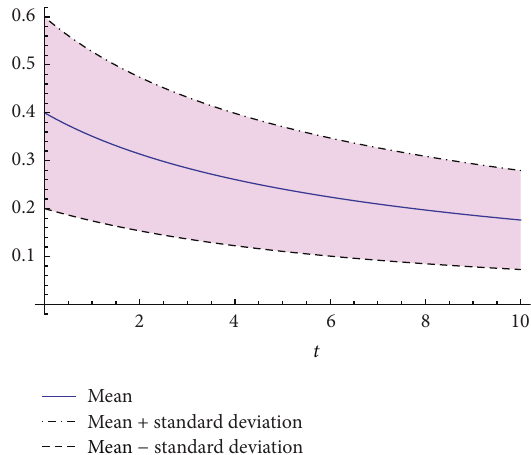
Figure 3: Approximations of the expectation (solid line) and plus/minusstandarddeviation(dashedlines)tothesolutions.p. 𝑦(𝑡) on the interval [0,10] in Example